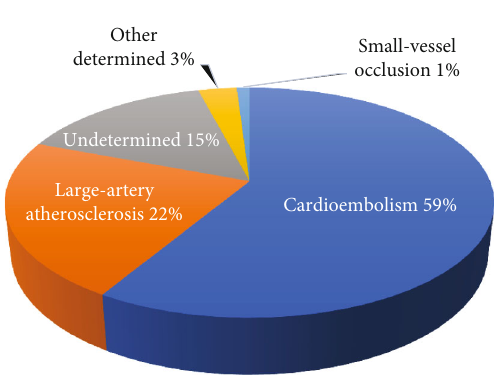
Figure 1: Stroke subtypes in patients with